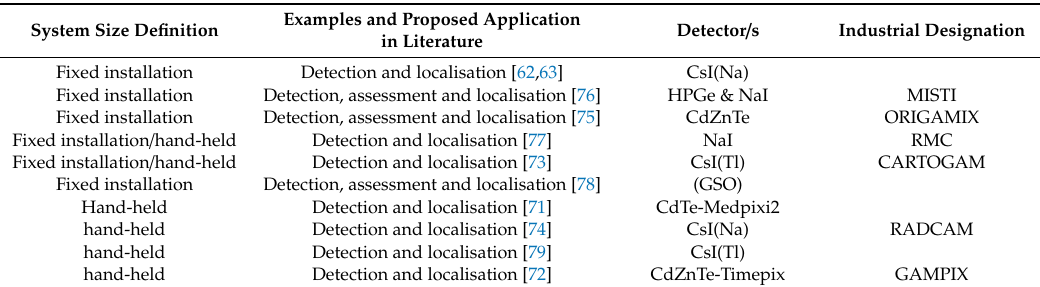
Table 3. Coded aperture-based gamma-imaging